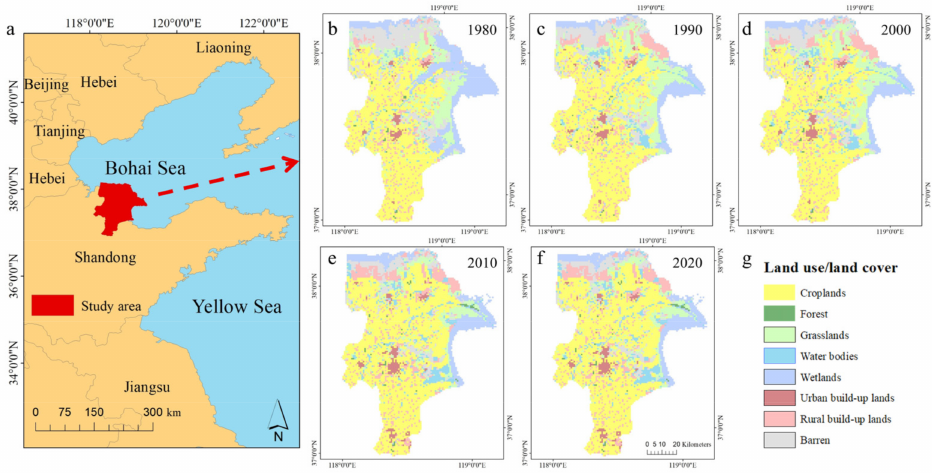
Figure 2. The location of Dongying city and its land use/land cover (LULC). ( a ) The location of Dongying city. ( b – f ) The LULC of Dongying city in 1980, 1990, 2000, 2010, and 2020, which was adopted from remote sensing monitoring data of LULC in China (http://www.dsac.cn/DataProduct/ Detail/200804) (accessed on 1 February 2023). ( g ) The legends of